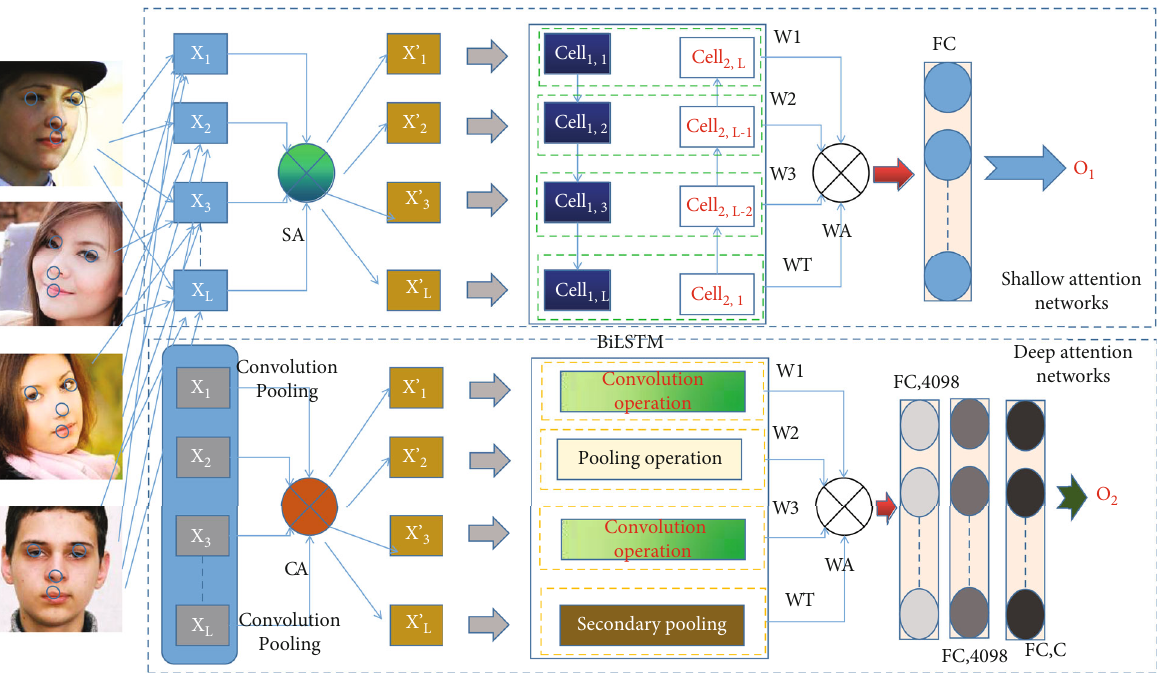
Figure 1: Fusion model of shallow and deep networks.